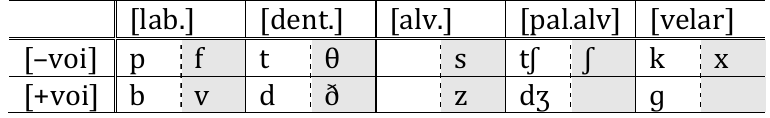
Table 4: The obstruents of Middle